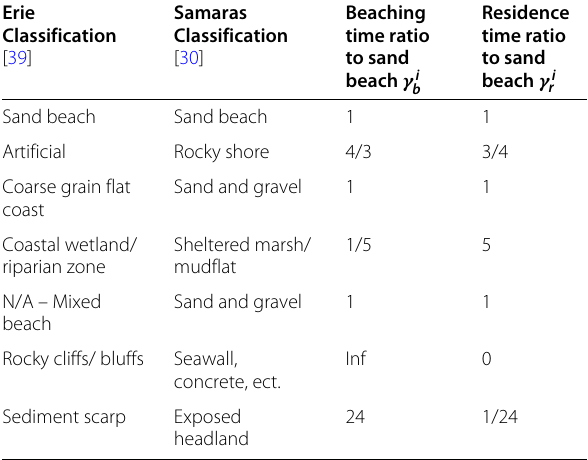
Table 1 Beaching time and residence time ratios to sand